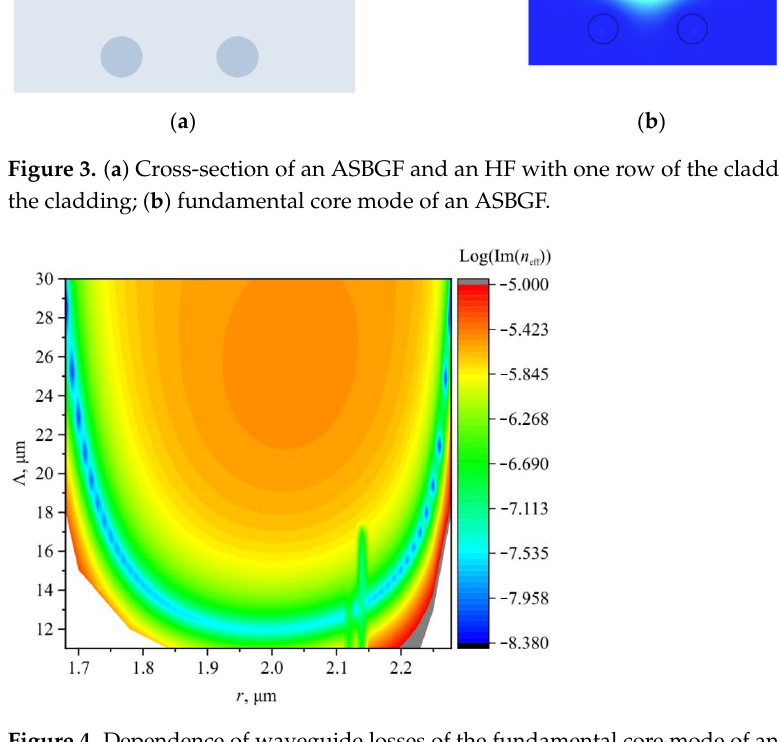
Figure 4. Dependence of waveguide losses of the fundamental core mode of an ASBGF with one row of the cladding rods on values of the cladding rod radius and the pitch at the refractive index contrast 0.05; the refractive index of the glass matrix is 1.45. The calculation was carried out at a wavelength of 1 µm for circular polarization. The loss behavior near the values of the cladding rod radius of 2.15 µ m is related to anti-crossing between the fundamental core mode and the cladding rod modes.